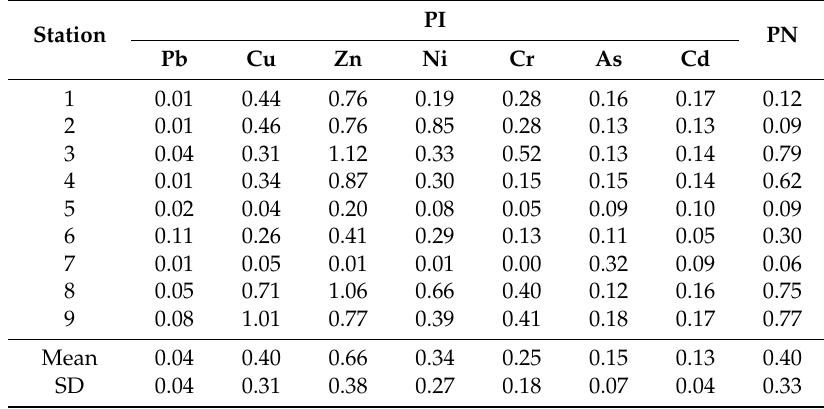
Table 4. Results of single factor pollution index (PI) and the Nemerow’s synthetic pollution index (PN) for heavy metals in sewage sludge for land